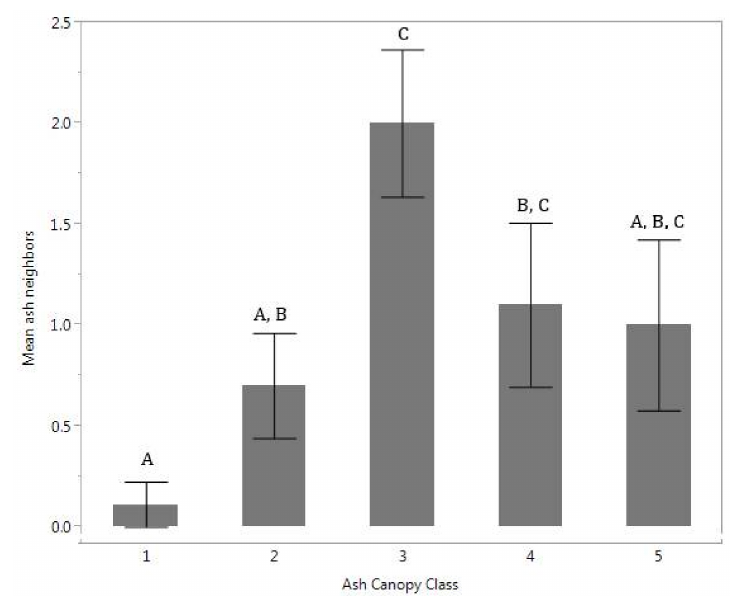
Figure 1. The mean number of ash neighbors within 6 m of focal ash trees within each ash canopy health class. Error bars represent ± one standard error Different letters (A, B, C) indicate significant differences in mean values, mean values with the same letters were similar and no statistically significant differences were observed for these samples. Ash canopy health class ratings are 1–5, where 1 is a full healthy crown to class 5, which is a dead crown.